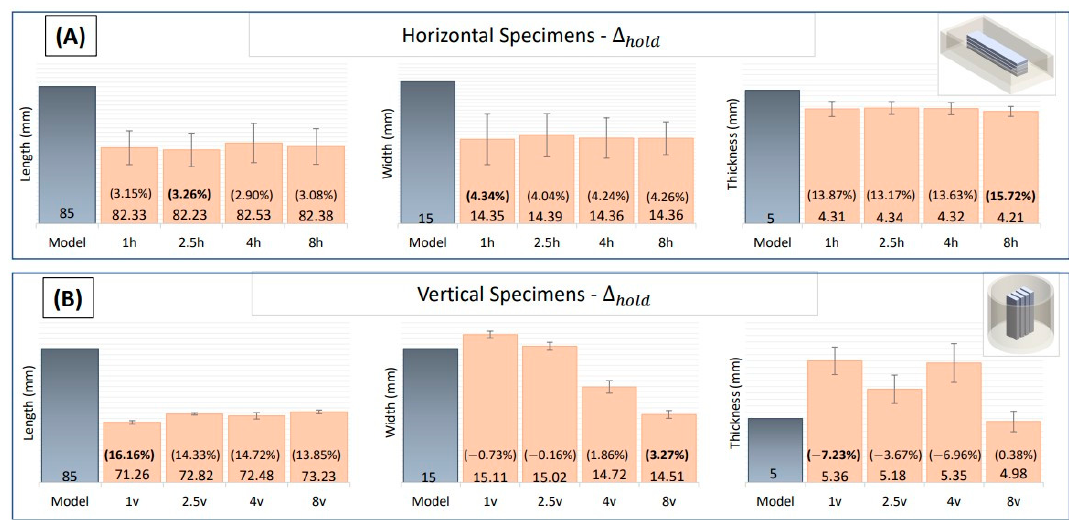
Figure 7. Average geometric distortion (shrinkage) of specimens under variable sintering hold time ( ∆ hold ). ( A ) Horizontally built specimens. ( B ) Vertically built specimens. Absolute values of each measure are in mm, and relative variation from CAD model is a percentage. Negative values indicate an increase in size.